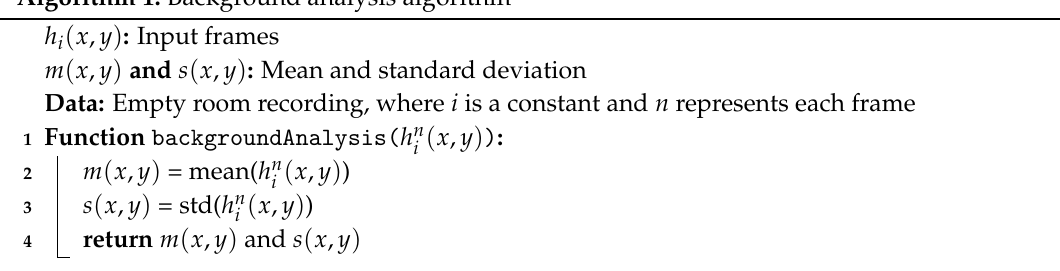
Algorithm 1: Background analysis